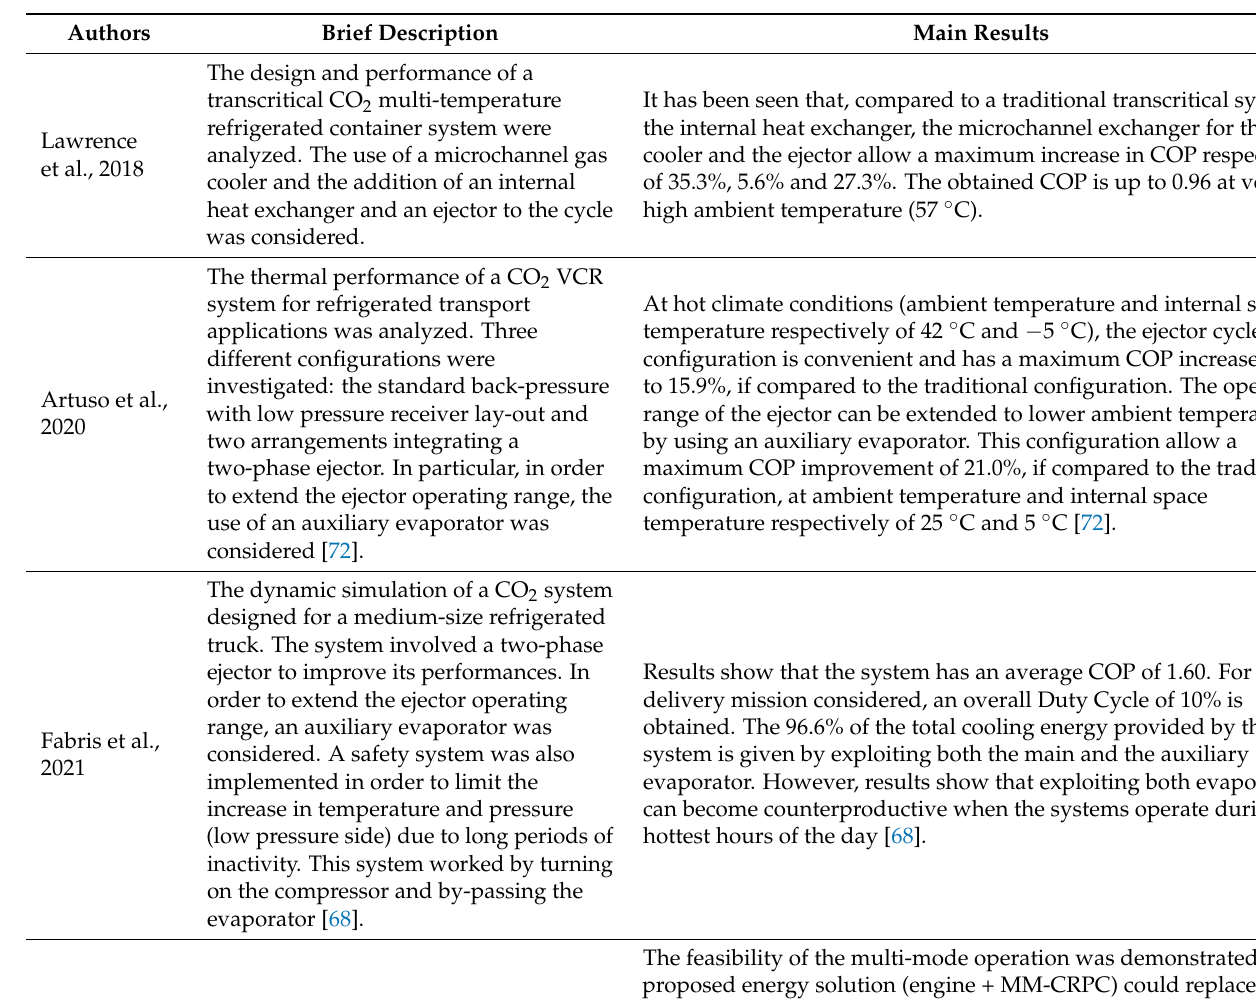
Table 12. Summary of proposed CO 2 refrigeration systems in refrigerated transport